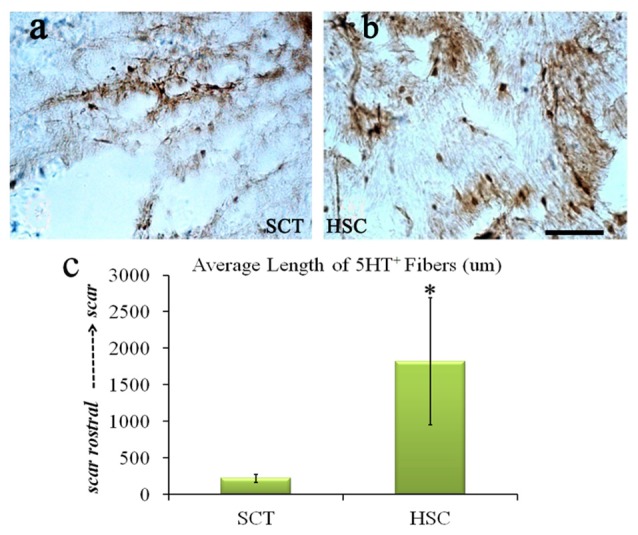
HSC transplantation enhanced the regeneration of 5-HT fibers. After SCT, 5-HT fiber exhibited weak regeneration capacity (A), while HSC transplantation largely increased the number of 5-HT positive fibers (B), the length is near 2 cm (C). Data are presented as the mean ± SD (n = 7). Student’s t test was used to analyze the data. *P < 0.05 vs. SCT. Bar = 50 μm.